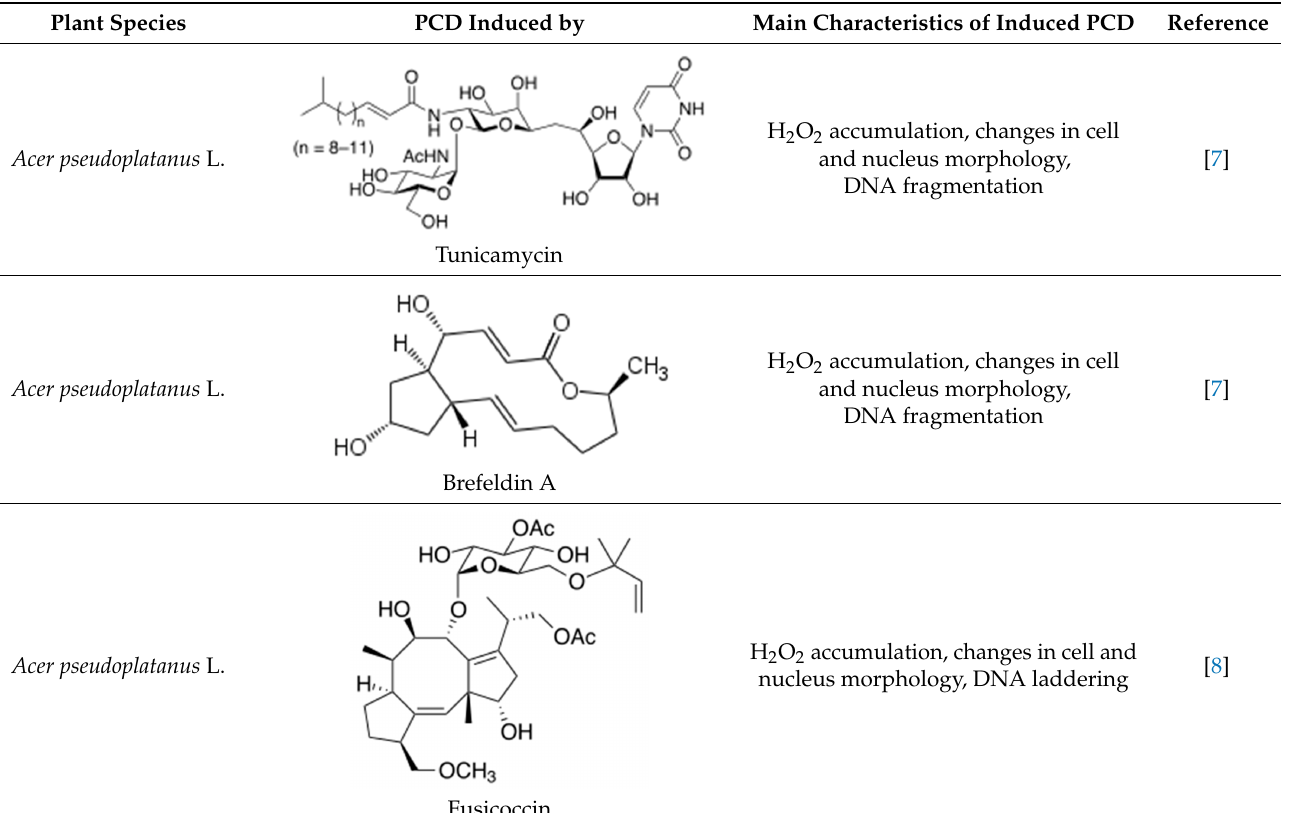
Table 1. Biotic programmed cell death (PCD) inducers in plant cell cultures. Plant Species